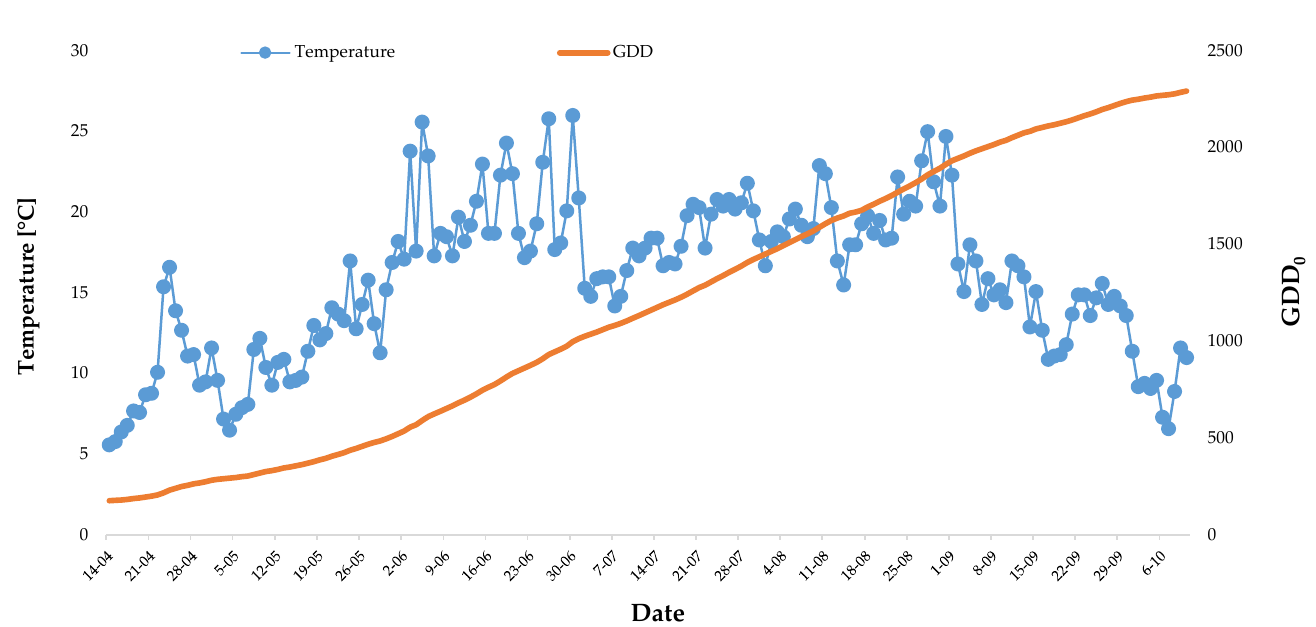
Figure 1. Average daily temperatures from sowing to harvesting of maize and growing degree days (GDD).